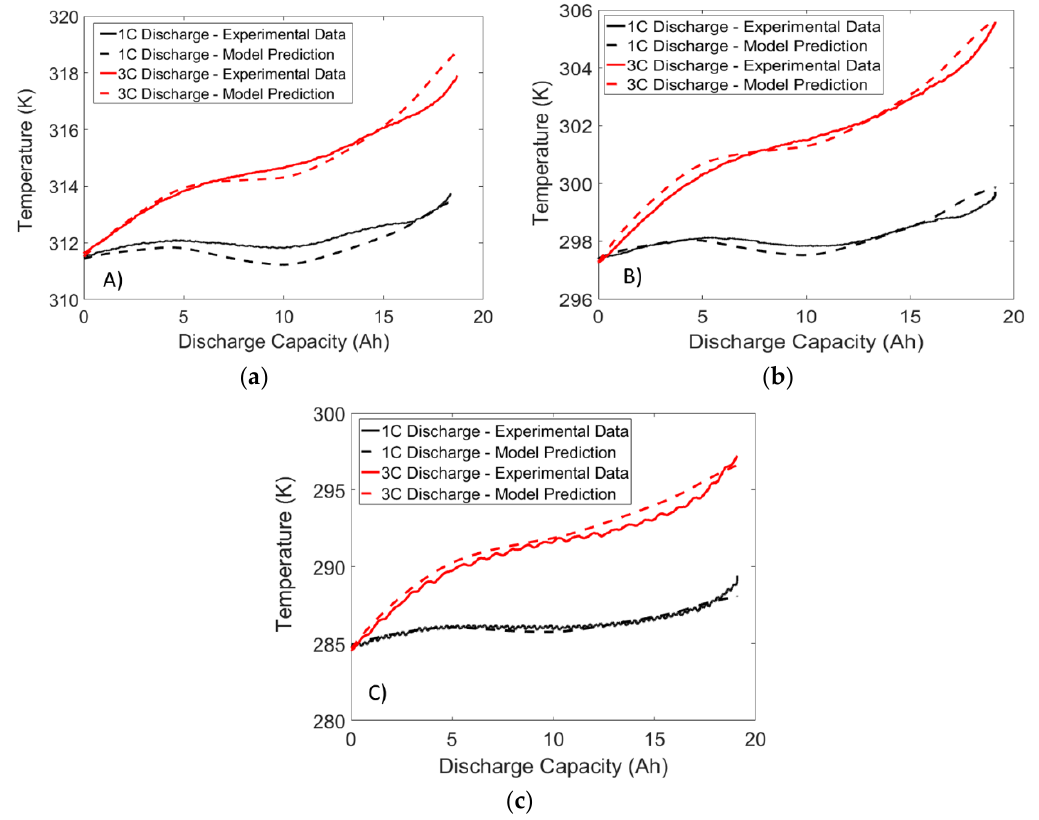
Figure 13. Temperature response of a LFP battery subjected to constant current 1C and 3C discharge at ambient temperatures of: ( a ) 40 °C; ( b ) 25 °C; and ( c ) 10 °C.